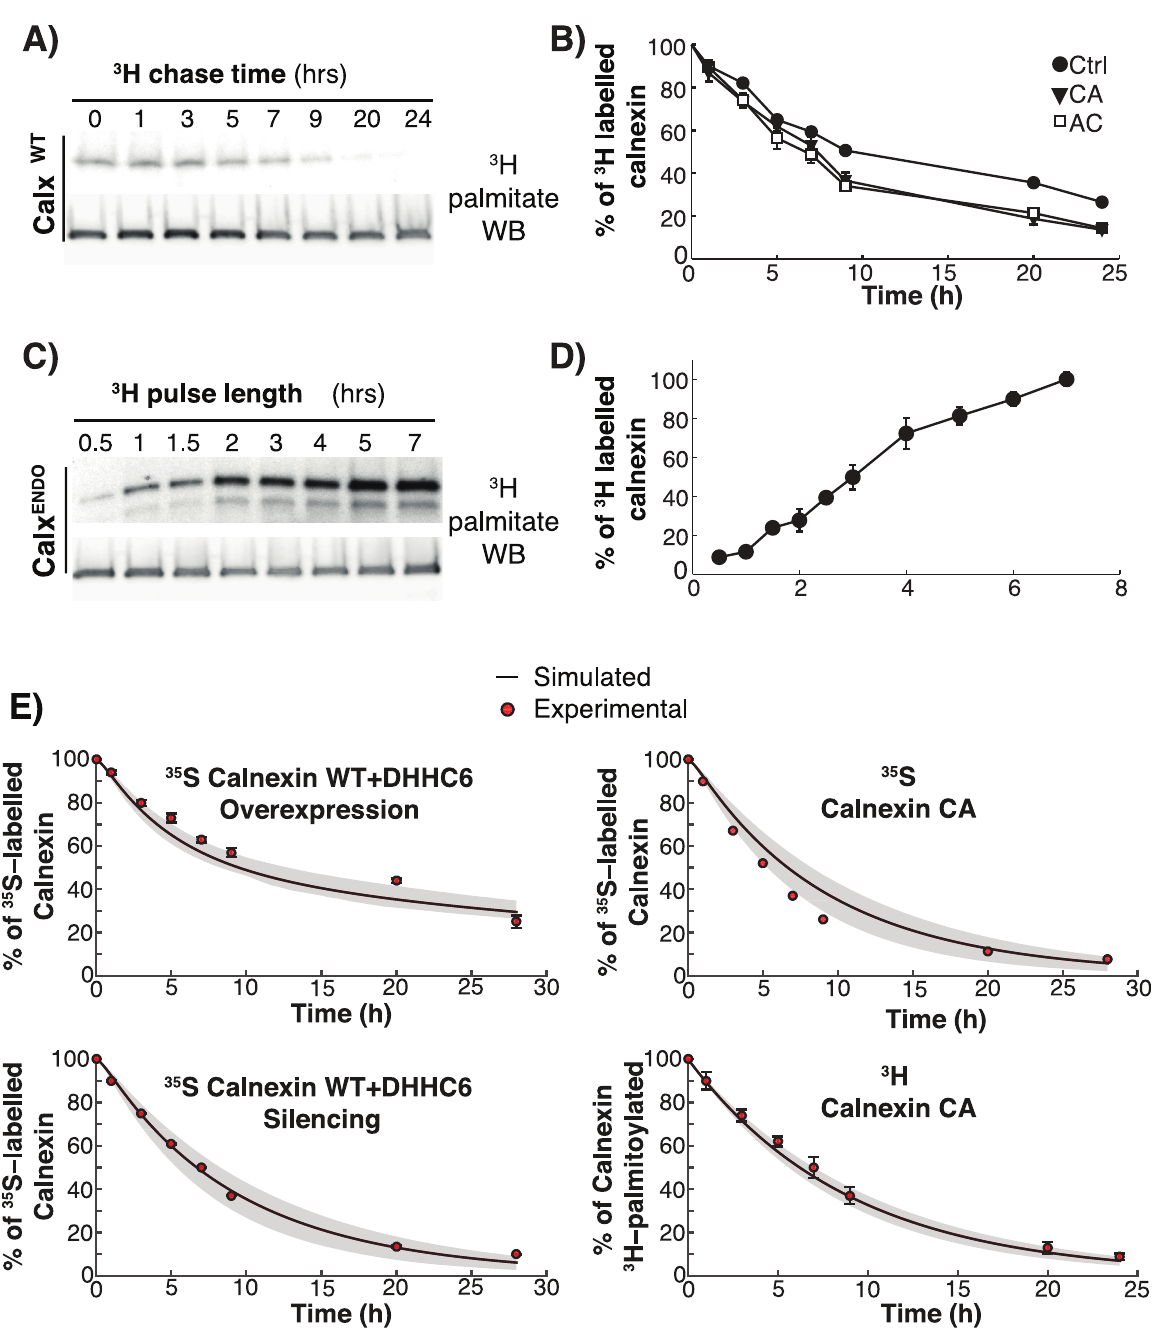
Fig 2. Experiments and modelling of Palmitoylation/depalmitoylation of calnexin. AB : HeLa cells were transfected for 24h with calnexin-WT-HA, calnexin-CA-HA, or calnexin-AC-HA. Cells were incubated with 3 H-palmitic acid for 2h, washed and further incubated for different times at 37°C in complete medium prior to immunoprecipitation using anti-calnexin or anti-HA antibodies. Immunoprecipitates were split into two, run on SDS-PAGE and analyzed either by autoradiography ( 3 H-palmitate) or Western blotting (anti-HA). Autoradiograms were quantified using the Typhoon Imager (Image QuantTool, GE healthcare). Errors correspond to standard deviations (n = 3). CD: HeLa cells were incubated with 3 H-palmitic acid for different times at 37°C, washed prior to immunoprecipitation using anti-calnexin antibodies. Immunoprecipitates were split into two, run on SDS-PAGE and analyzed either by autoradiography ( 3 H- palmitate) or Western blotting (anti-calnexin). Errors correspond to standard deviations (n = 4). E: Validation of the model output though comparison of the in silico experiments with experimental data that was not used in the calibration of the model. Solid line is the mean of the simulations of 382 models; the shaded area is defined by the first and the third quartile of the simulations of 382 models (details of the in silico labelling experiment can be found in the Supplemental Information).